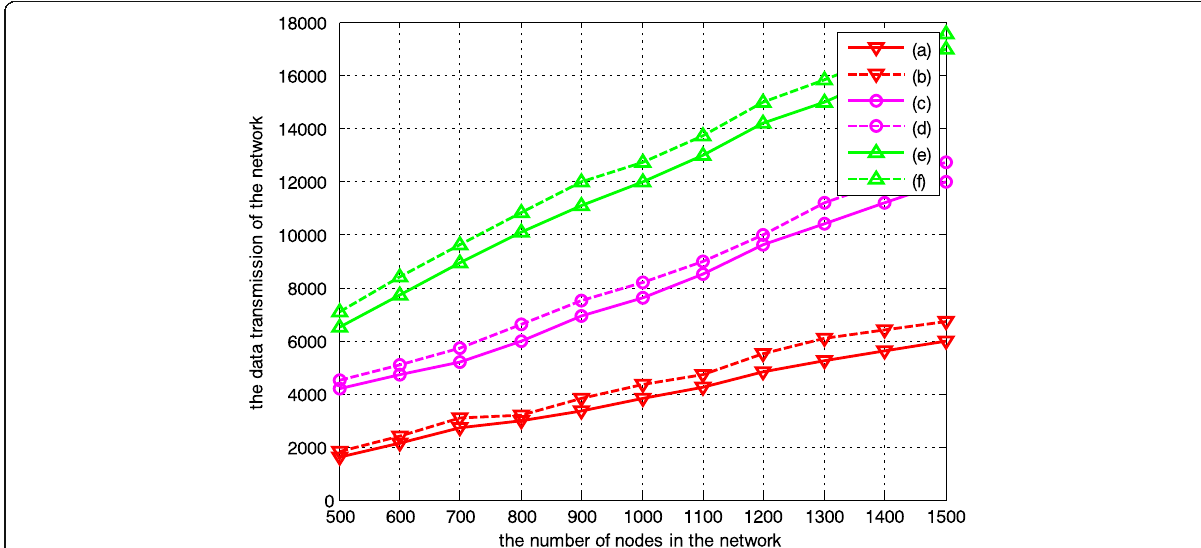
Fig. 5 Comparison of data packet transmission of various